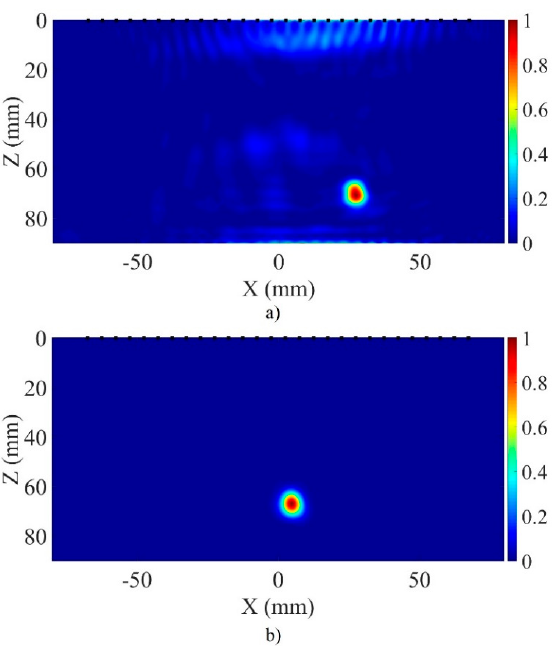
Figure 8. Reconstructed mm-wave image for ( a ) Test 1 and ( b ) Test 2 .